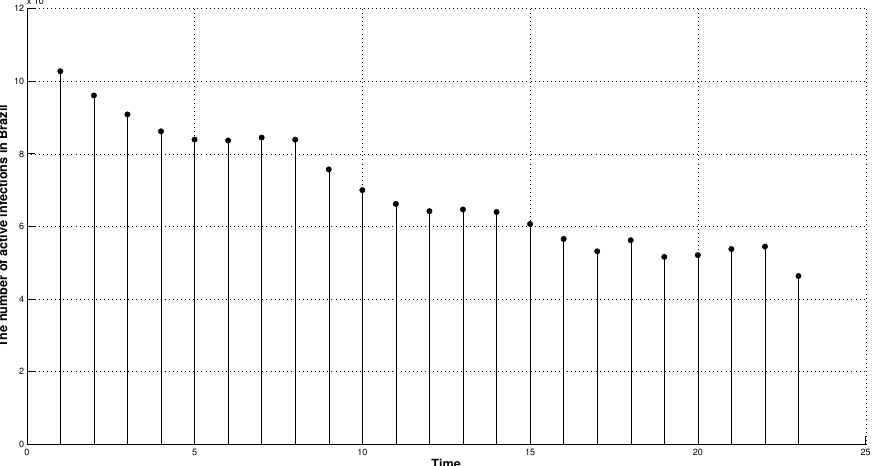
Figure 1. The number of active infections in Brazil in the period from 23 July to 15 August 2022